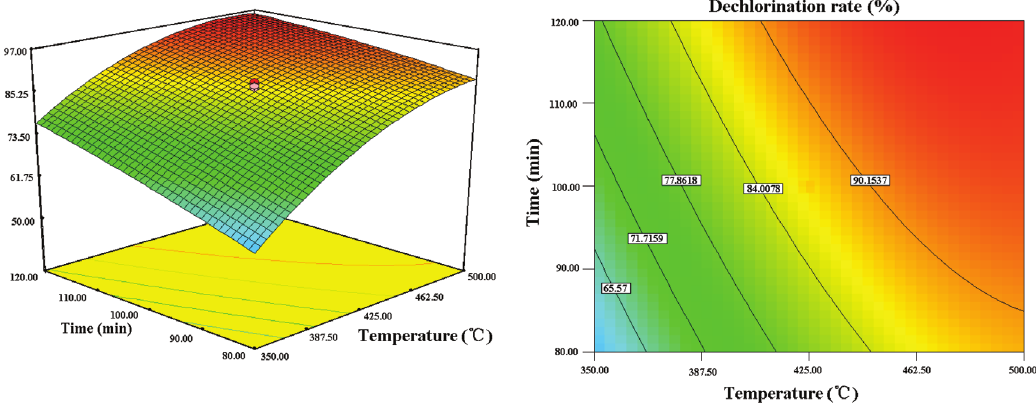
Figure 4: The interactive effects of the temperature and roasting time on the dechlorination rate by microwave roasting under oxygen- enriched